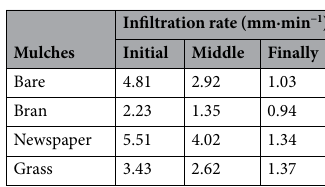
Table 1. Infiltration rate characteristics of different organic mulches.